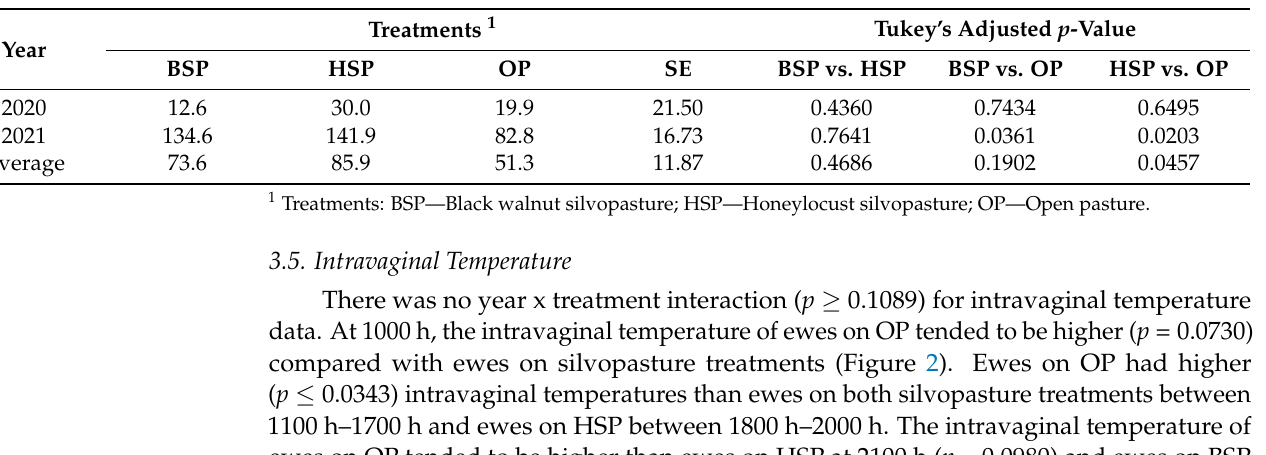
Table 5. Average daily gain (g day − 1 ) of Katahdin ewes that grazed either open pasture (OP), black walnut silvopasture (BSP), or honeylocust silvopasture (HSP) treatments during the summers of 2020 and 2021.